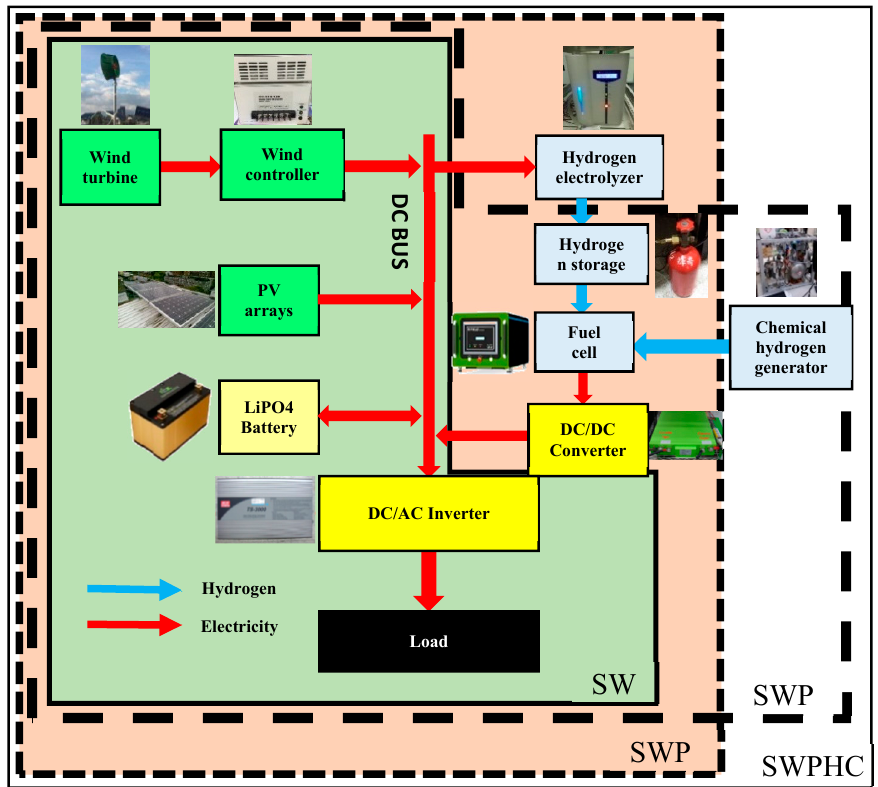
Figure 8. The four hybrid power models.